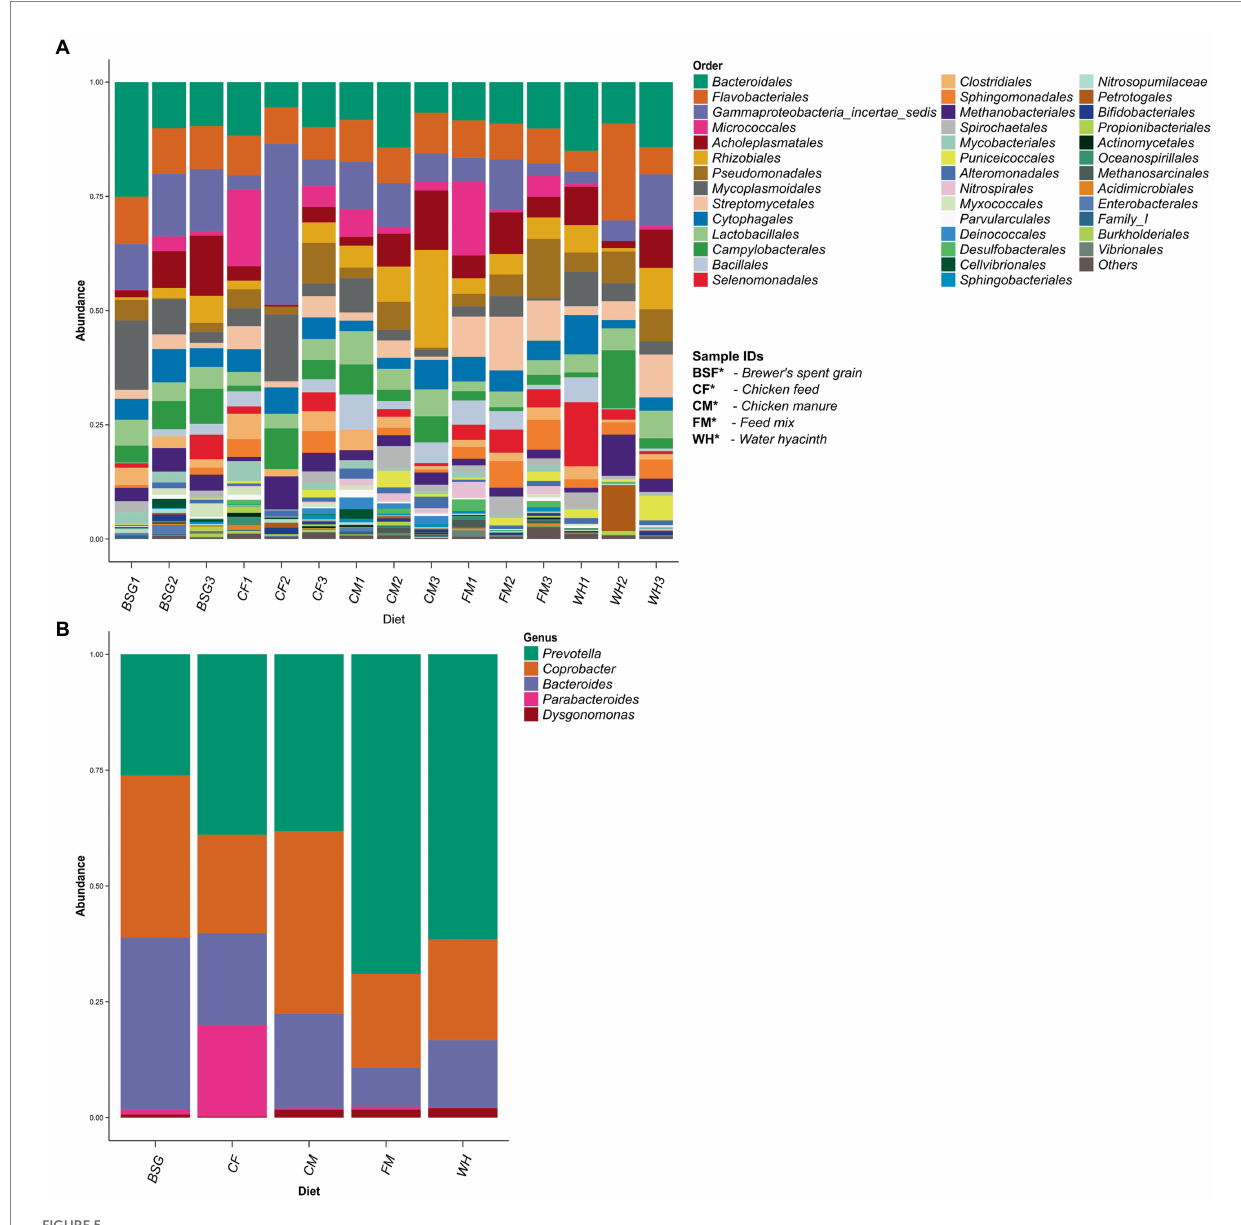
FIGURE 5 Taxonomic profiling using filtered 16S rRNA sequence reads. Taxonomic orders identified from 16S rRNA profiling (A) . A subset of order Bacteroidales – one of the most prevalent orders identified after 16S taxonomic profiling (B)